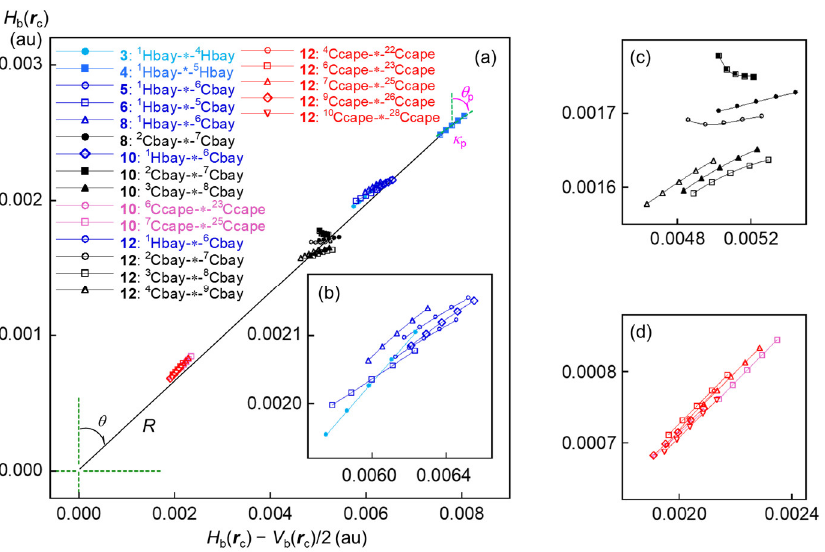
Figure 3. Plots of H b ( r c ) versus H b ( r c ) − V b ( r c )/2 for H-  -H, C-  -H, and C-  -C, exemplified by those